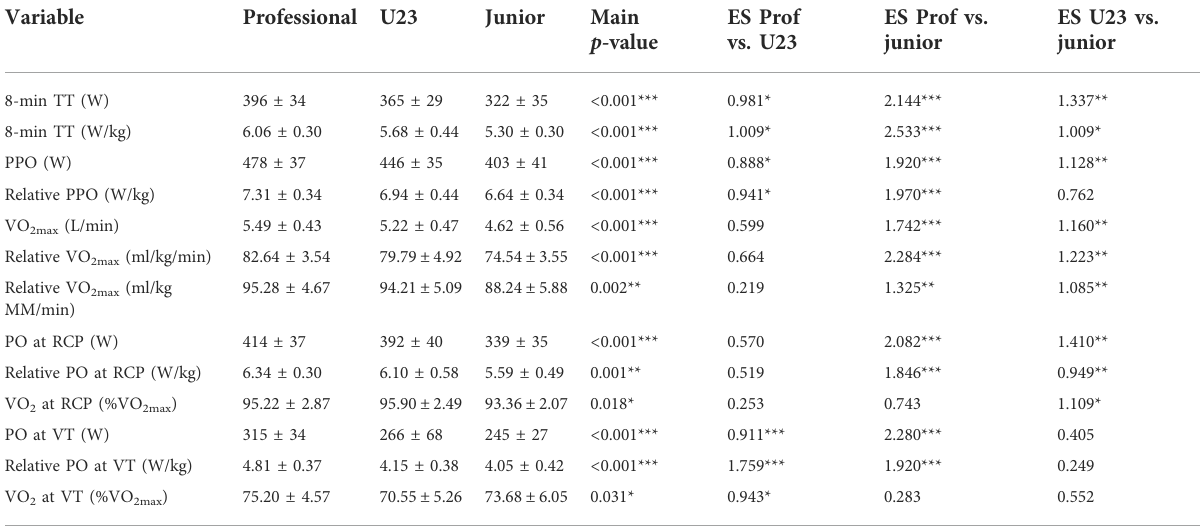
TABLE 1 Differences in endurance indicators between groups. Variable